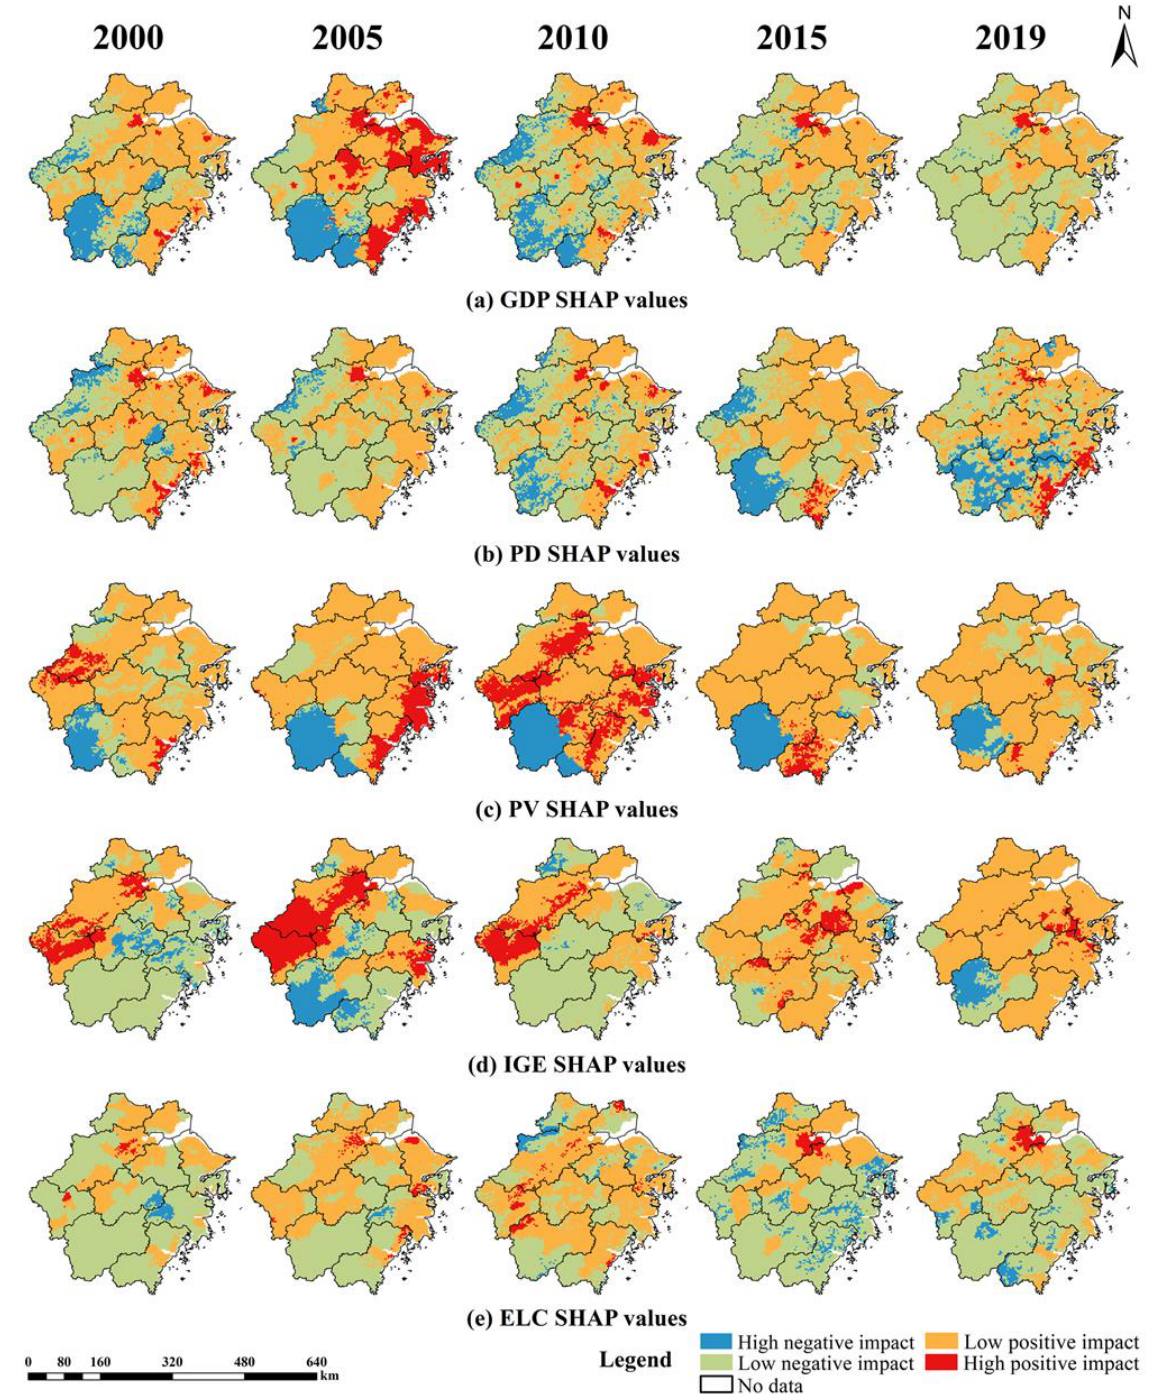
Figure 10. Spatiotemporal variations in SHAP values for socioeconomic factors.